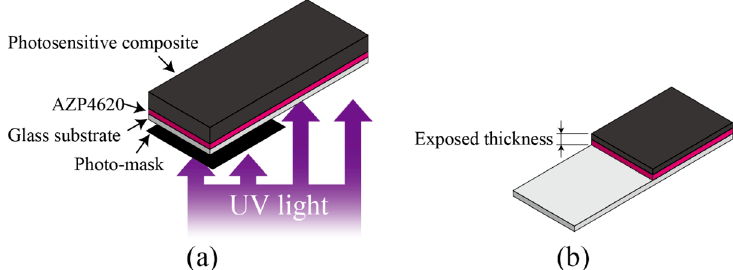
Figure 2. Evaluation method for exposure thickness of composite. Schematic diagrams for ( a ) exposure process and ( b ) after development process.